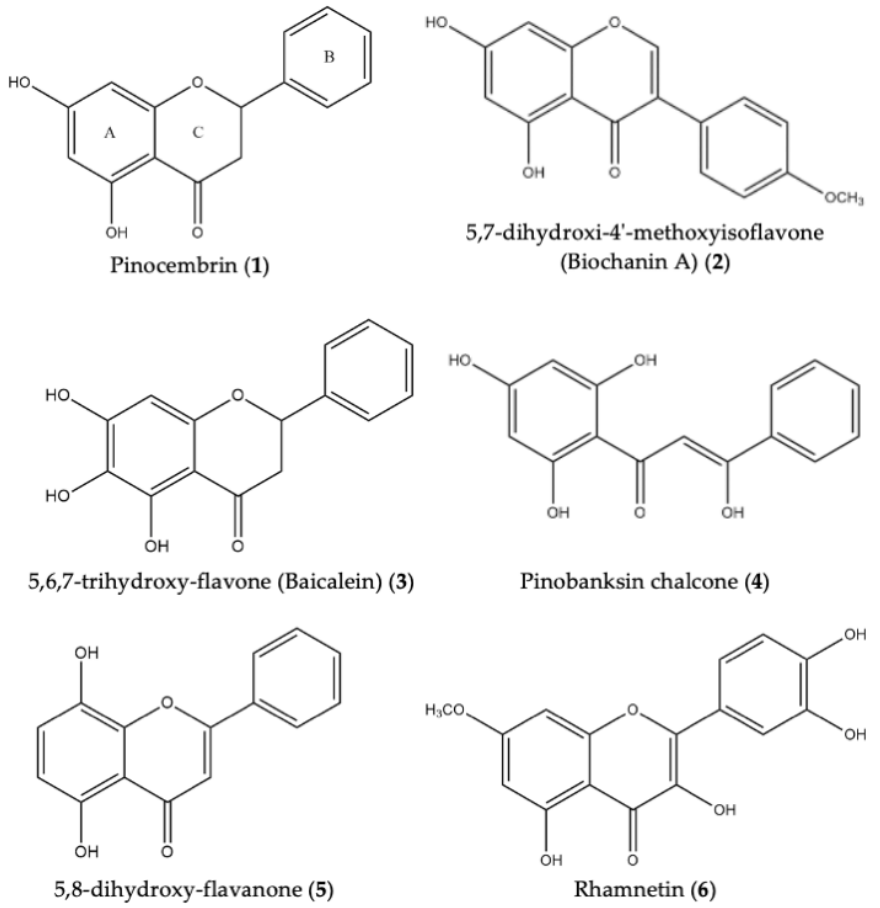
Figure 4. Structural formulas of flavonoids present in Mexican propolis.